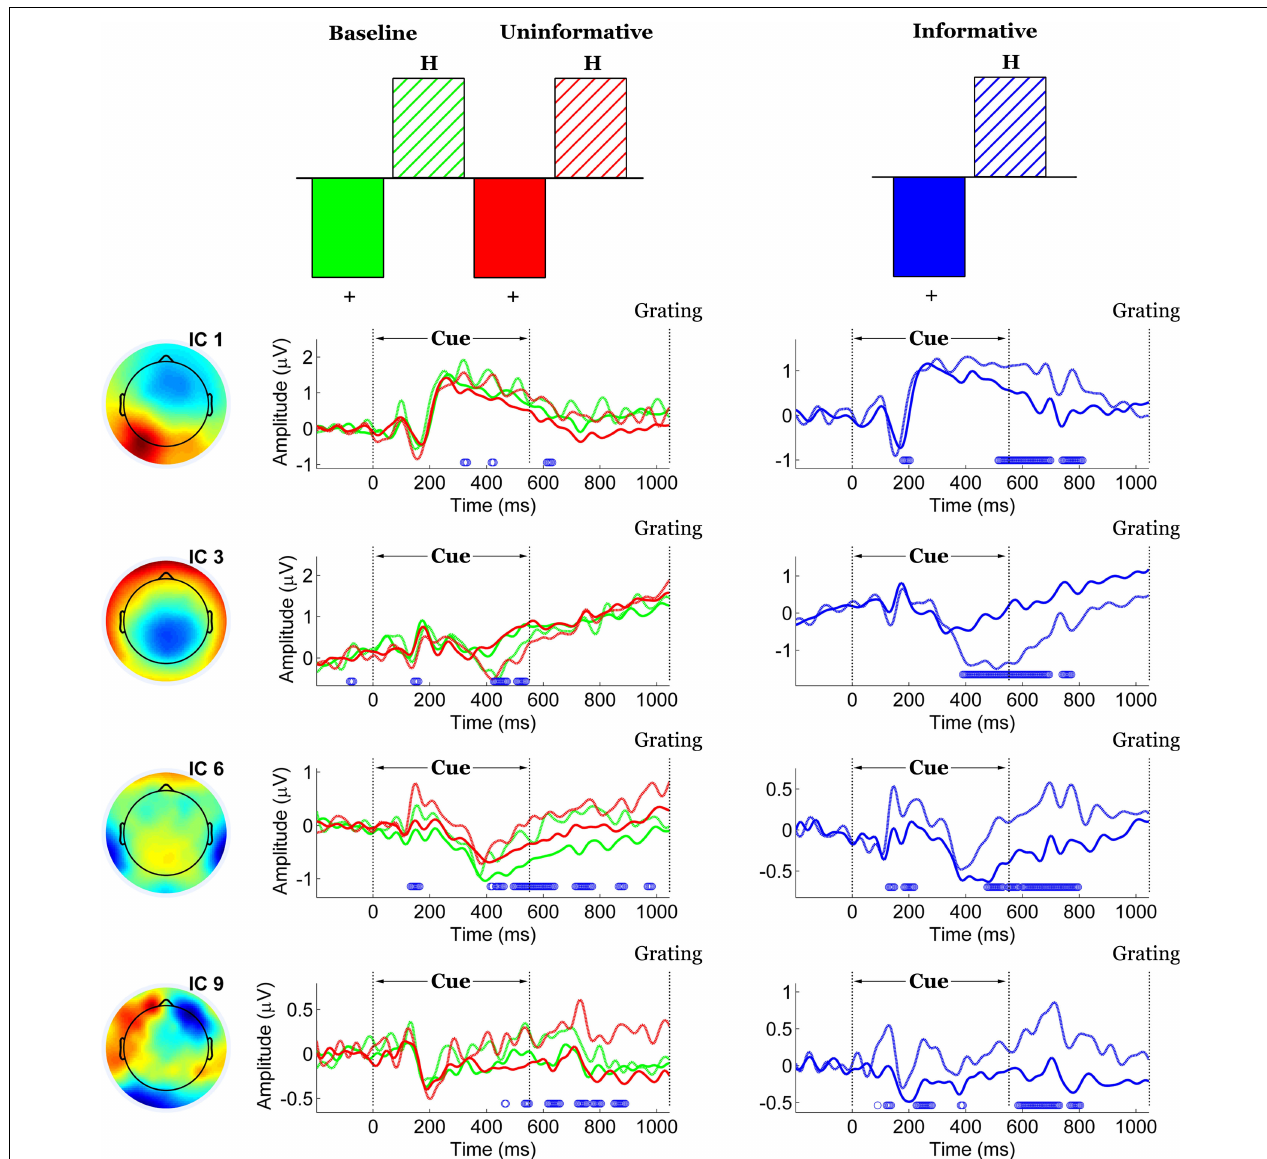
FIGURE 7 | Spatiotemporal patterns of scalp activity that differentiate “ + ” cue and “H” cue trials, separately for the Uninformative/Baseline conditions and for the Informative condition. Top: schematic indicates how the statistical